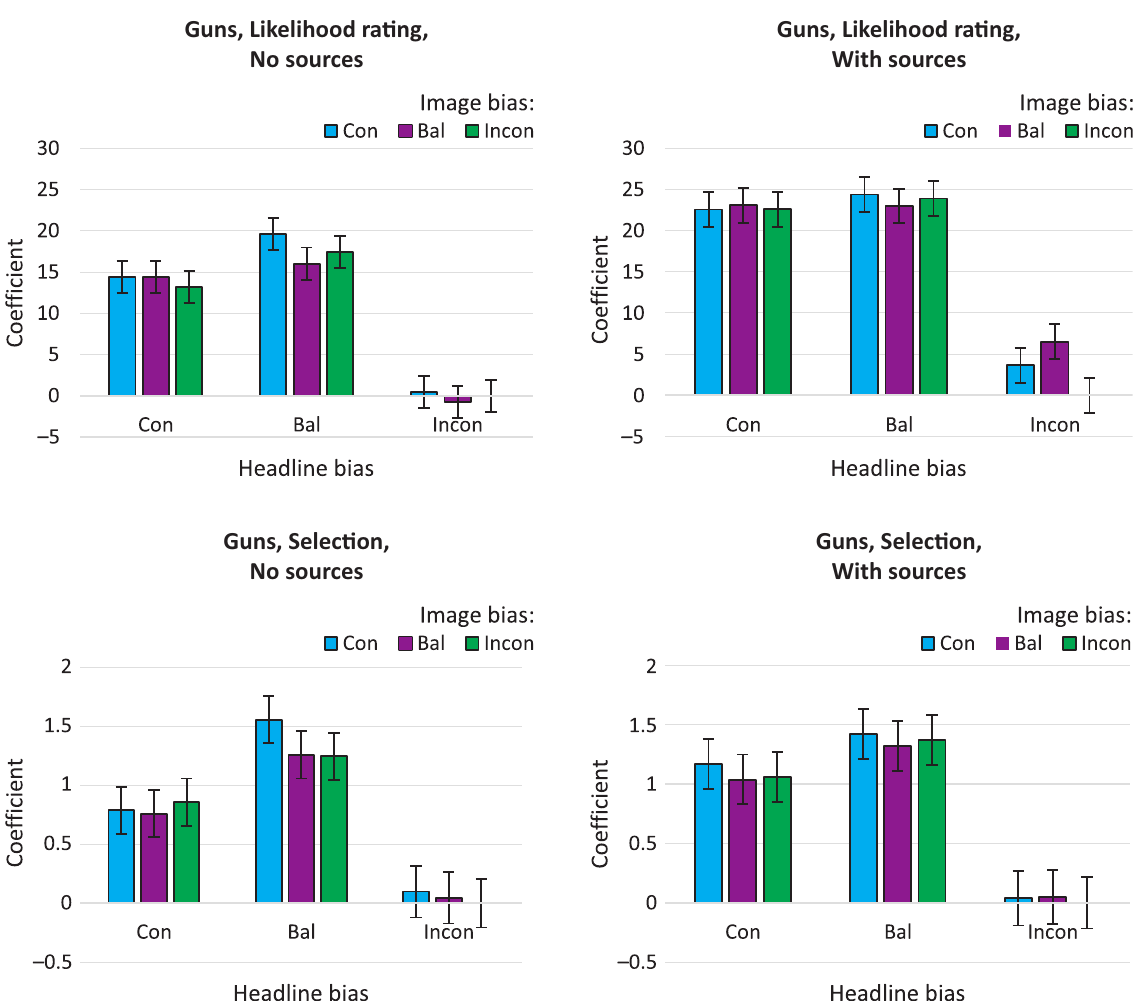
Figure 5. Coefficient plot comparing the selection of gun control news items with matching and non-matching headlines and images. Notes: Incon-Incon condition is used as the reference category. Regression coefficients and standard errors are plotted. Con = attitude congruent; Bal = balanced; Incon = attitude